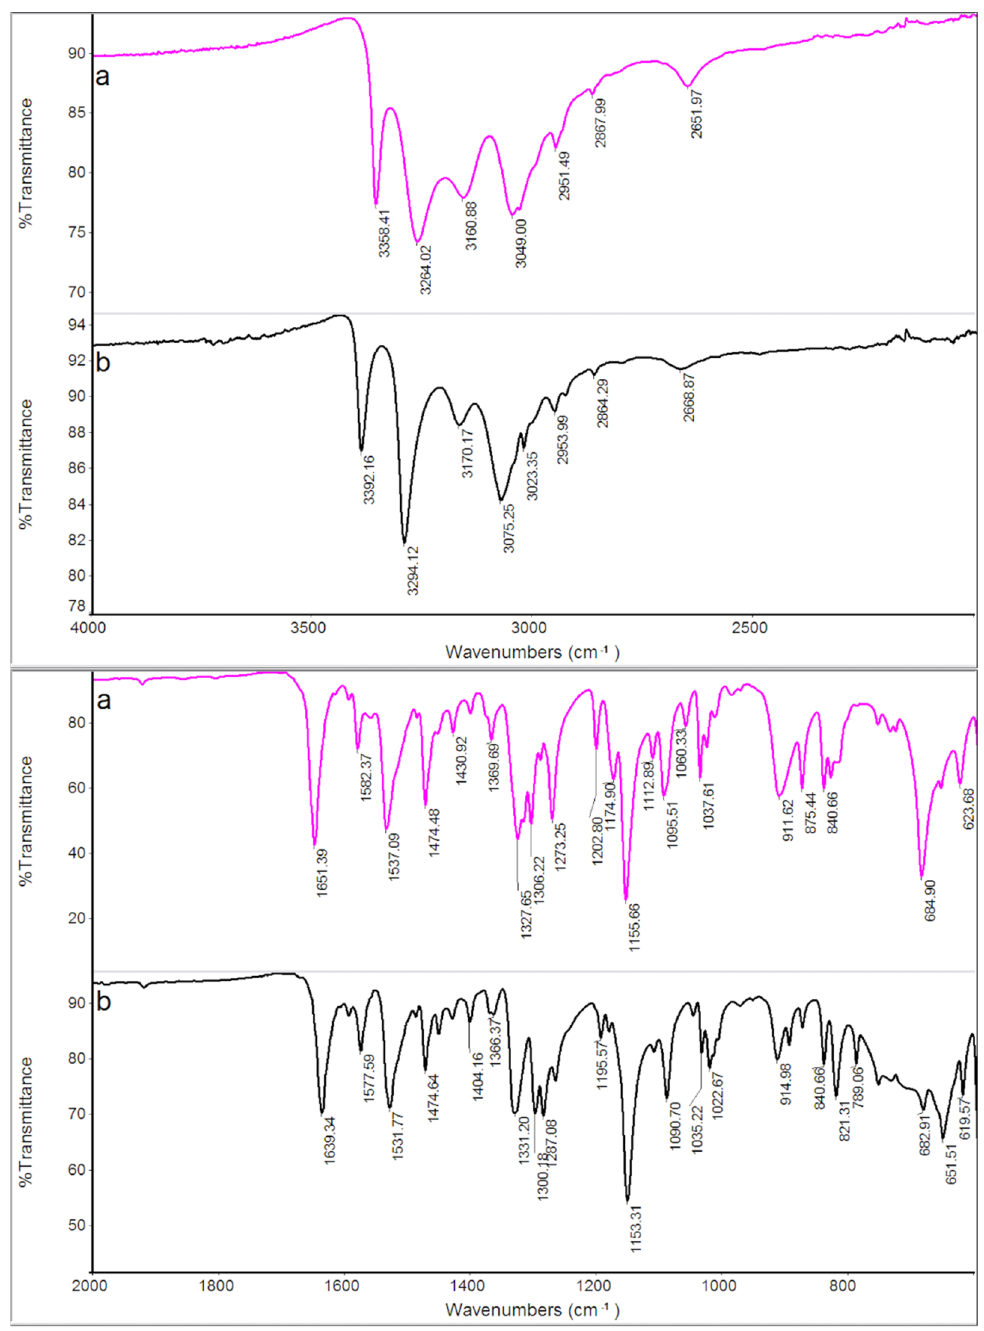
Figure 9. FT-IR spectra of GS ( a ) and GS * ( b ) samples.